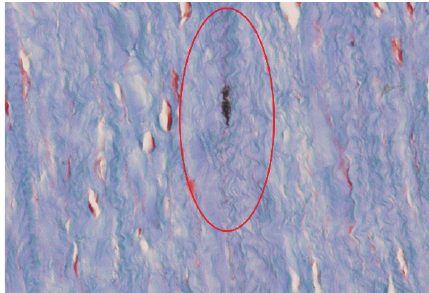
Figure 6: Corneal stroma sample vertically oriented with Masson trichrome staining. Red circle showing the strong adhesion of the tissue around the CNTs.